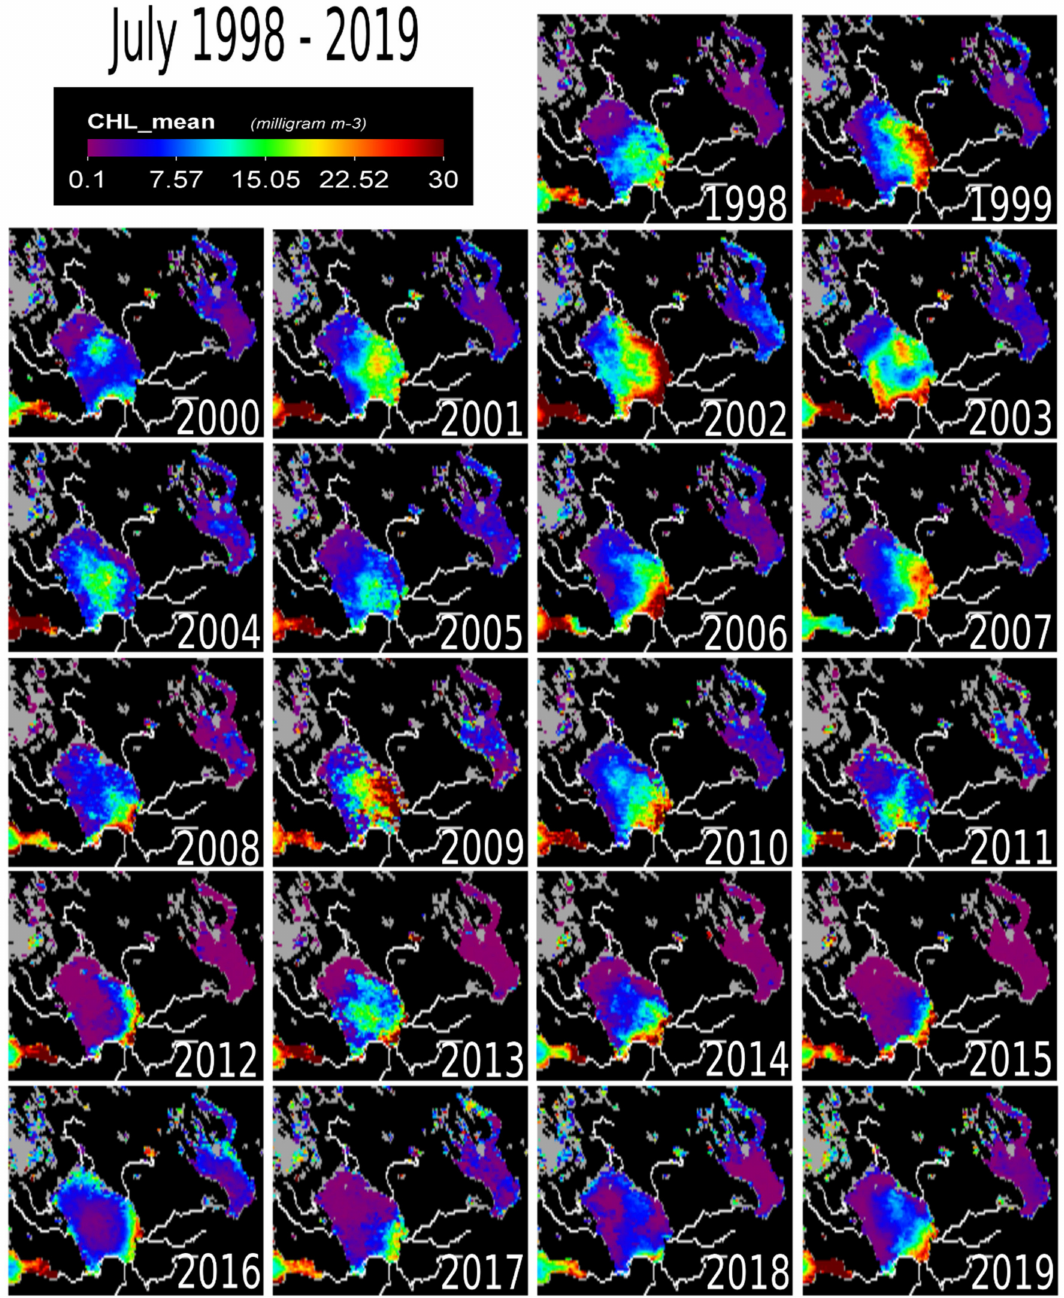
Figure 4. The map of chlorophyll-a concentration at Lake Ladoga for the month of July (1998–2019). Partially displayed as reference points are the Gulf of Finland (Southwest) and Lake Onega